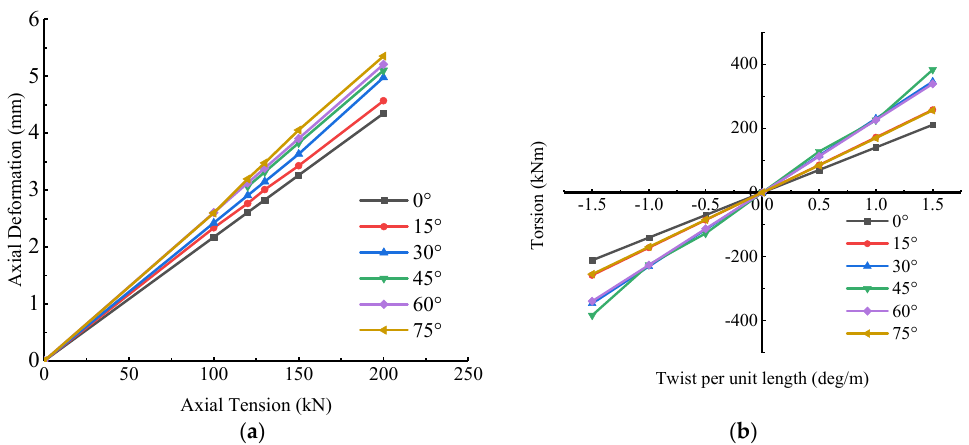
Figure 8. Displacement of flexible riser under tension and torsion. ( a ) Axial deformation versus tension per unit length, ( b ) twist versus torsion per unit length.